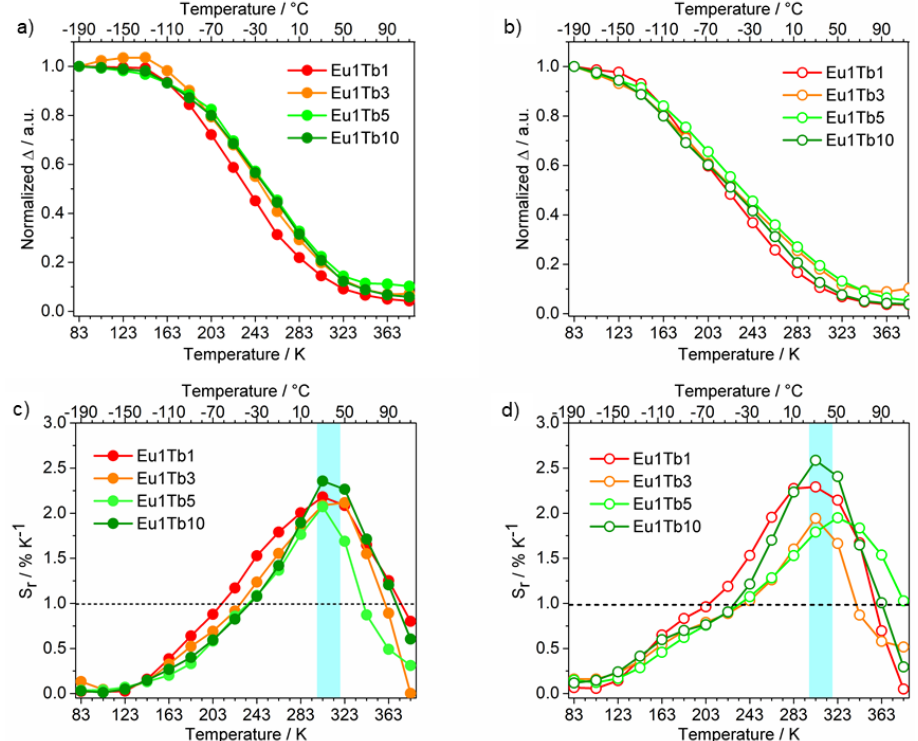
Figure 8. ( a , b ) Normalized ∆ vs. T and ( c , d ) S r curves of Eu − Tb mixed samples; in light blue is reported the physiological temperature range. ( a − c ) λ exc = 320 nm, ( b − d ) λ exc = 370 nm.